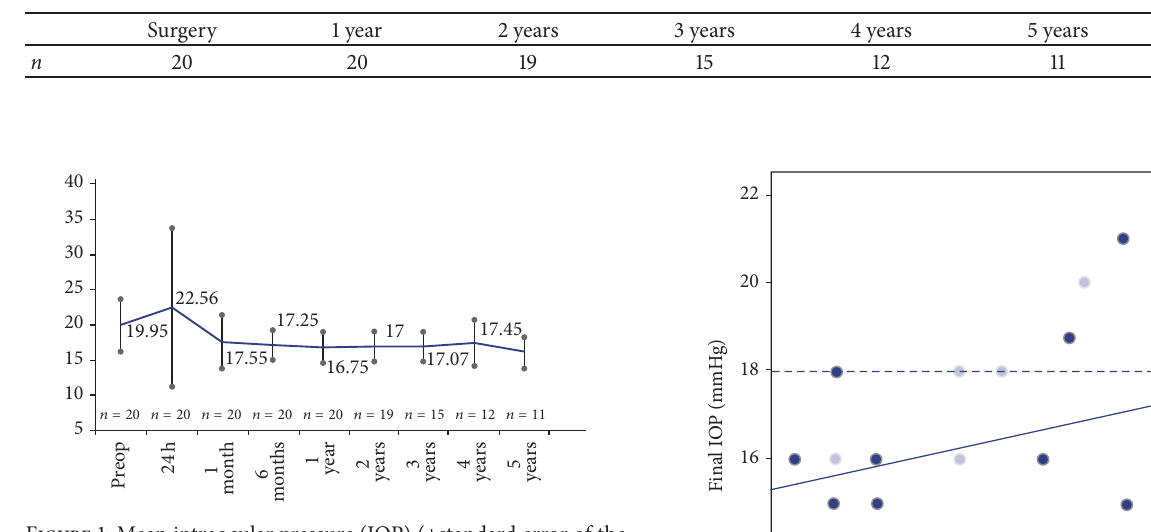
Table 2: Number of antiglaucoma medications used at baseline and final follow-up.